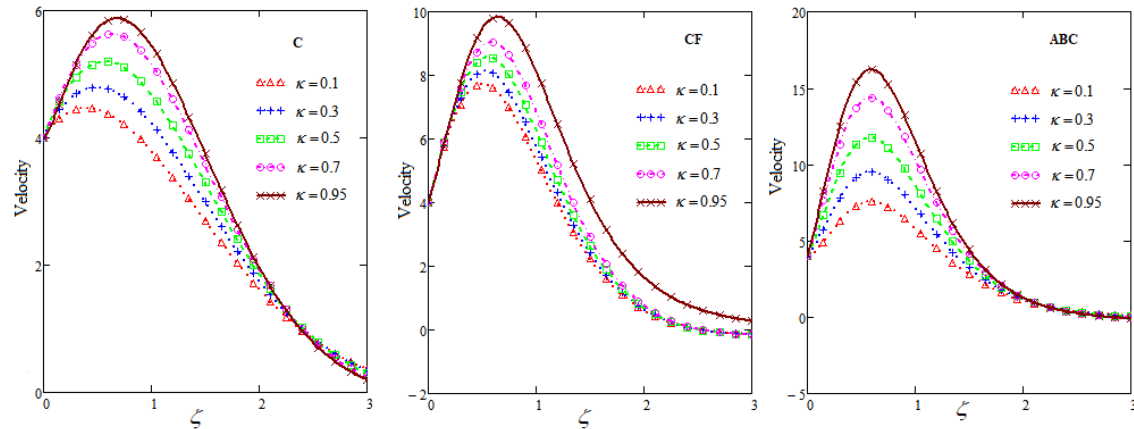
Figure 3. Velocity curves corresponding to C, CF and ABC with variable κ where P r = 7, S c = 0.66, G r = 10, G m = 5, H = 3, R = 5, S r = 3, K r = 2, M = 0.5, γ 1 = 0.1, h = 0.5, c = 1.05 and b = 0.75.